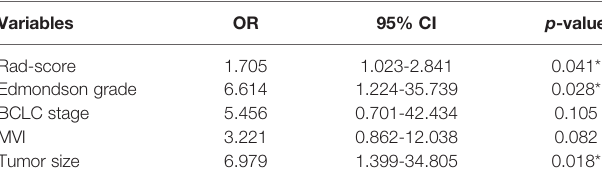
TABLE 3 | Multivariate logistic regression analysis of the Rad-score and clinical- radiological factors for ER in the training set.